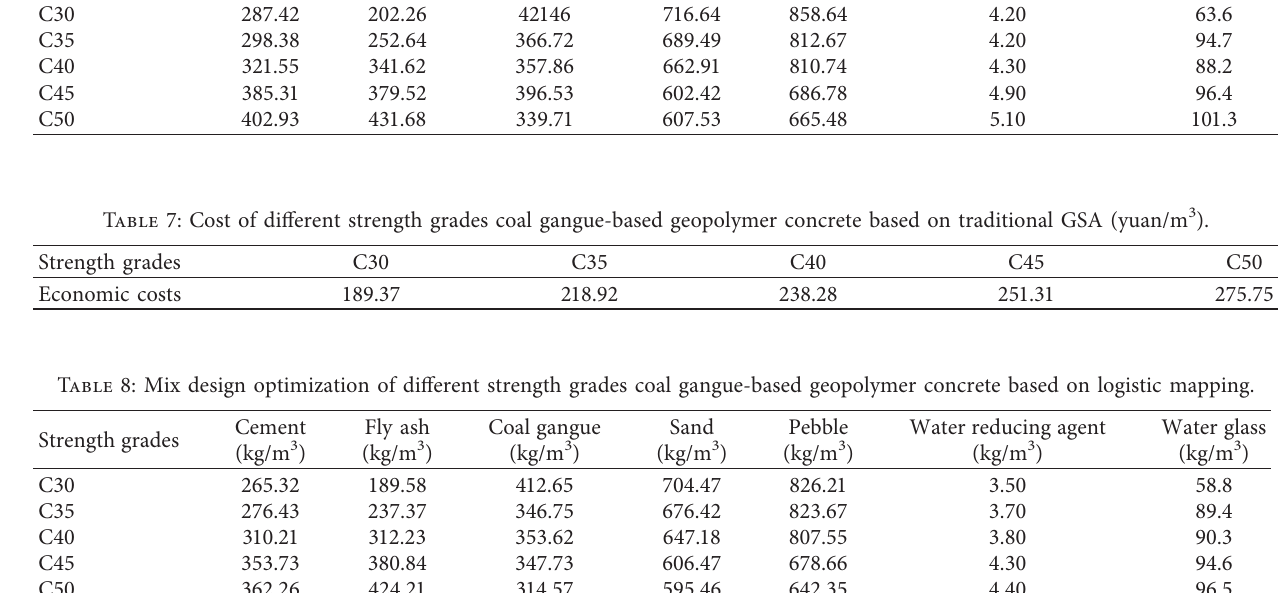
Table 6: Mix design optimization of different strength grades coal gangue-based geopolymer concrete based on traditional GSA. Strength grades